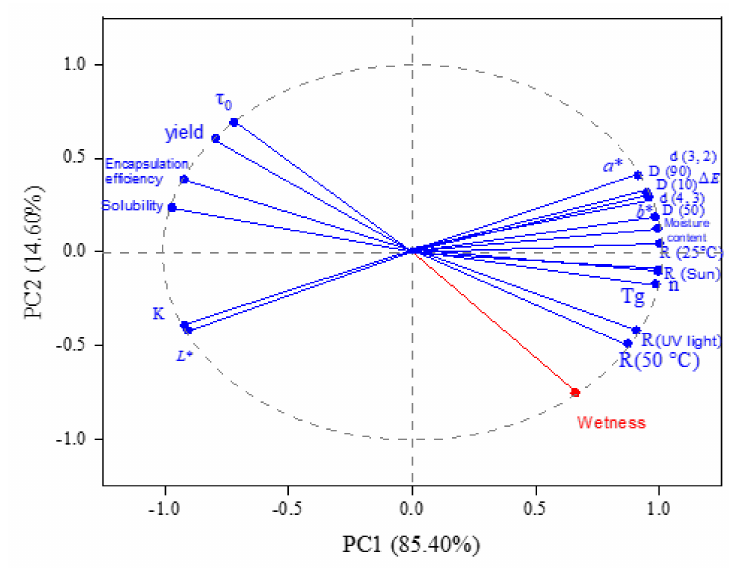
Figure 7. Principal component analysis of group